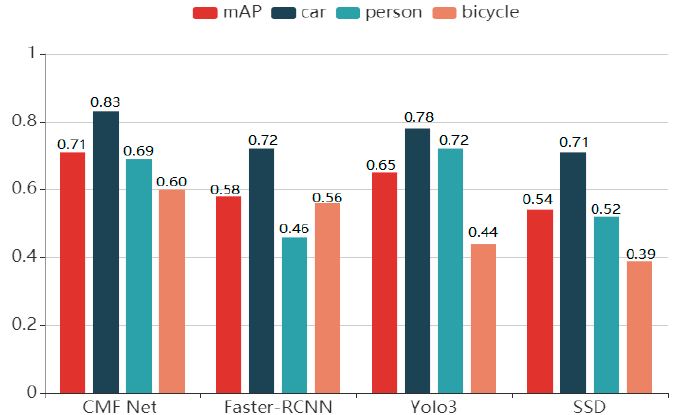
Figure 9. Performance comparison between CMF Net and other target detection models.